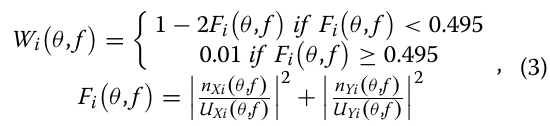
0° and other rotation angles (–40°––10°, 10°–40°), = =